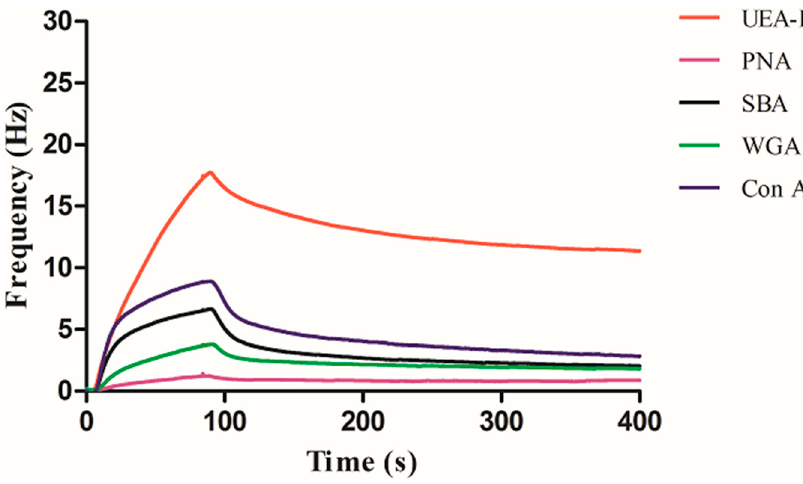
Figure 7. Interaction of fucose with a series of lectins.